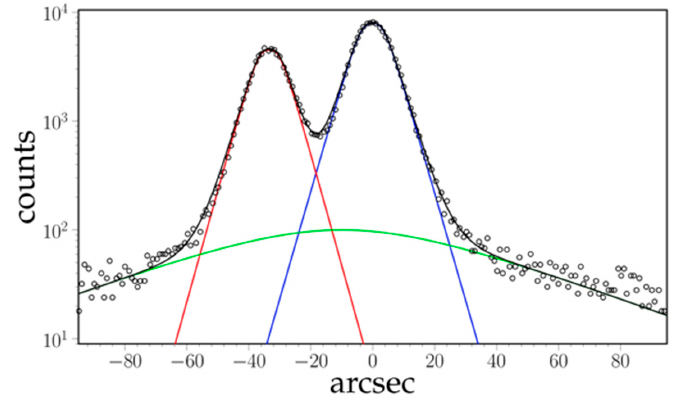
Figure 3. Typical X-ray data and fit of TCD intensity profile for the two peaks of phases 𝛾 (red) and 𝛾′